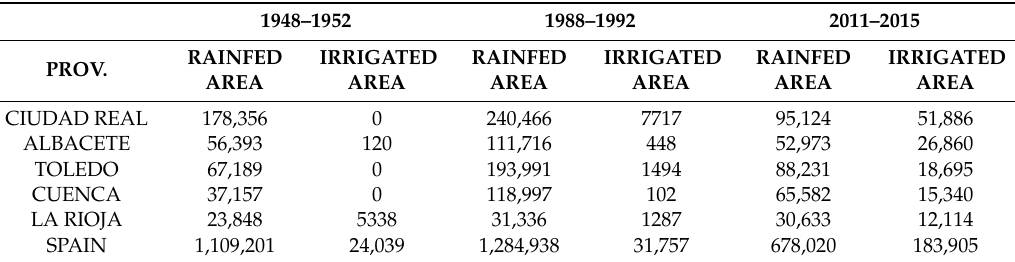
Figure 1. Evolution in Spain of the rainfed and irrigated areas dedicated to grape growing for wine, 1930-2015 (Ha). Source: Own calculation based on Anuario Estadístico de la Producción Agraria [56]. Table 1. Average rainfed and irrigated vineyard areas of Spain (in